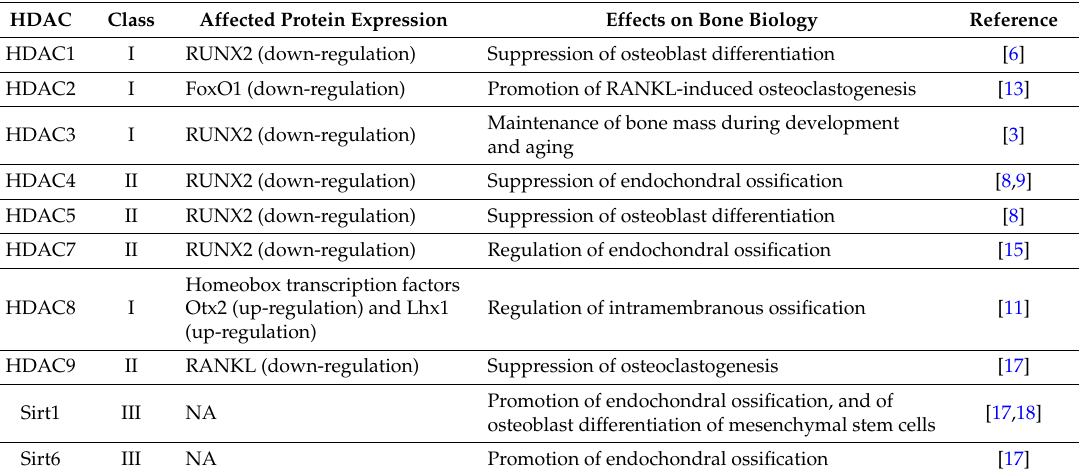
Table 2. Role of histone deacetylases (HDACs) in bone